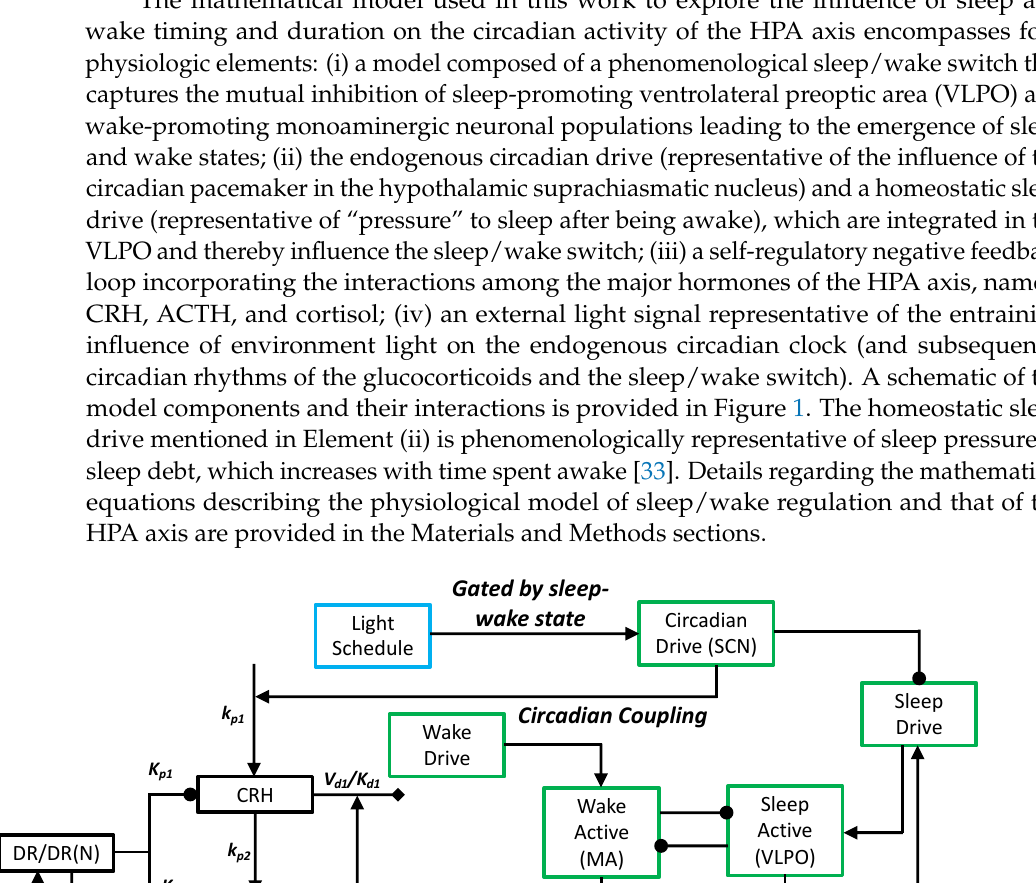
Figure 2. ( A) Forty-eight hours of the nominal light schedule [maximal light intensity of 1000 lux after simulated sunrise (6 a.m.) and a minimal light intensity of 0 lux after simulated sunset (6 p.m.)] used for model simulations. (B) The mean- field firing rates of the wake-active, MA (blue), and sleep-active, VLPO (red) populations across 48 h. The model describes